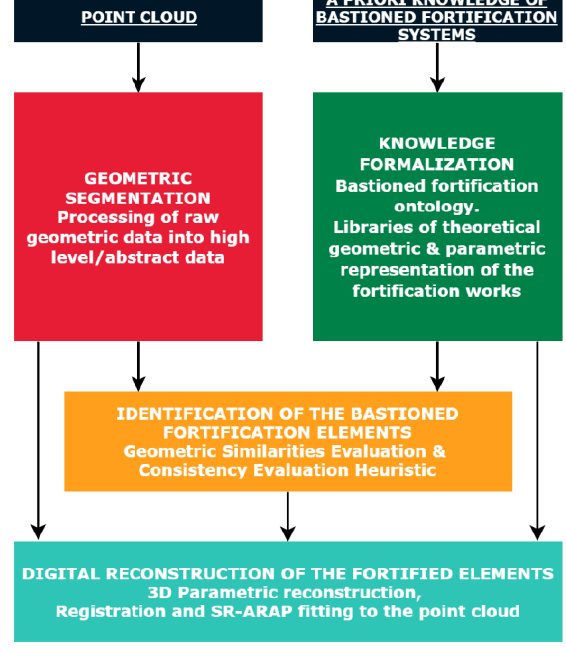
Figure 2. Framework simplified